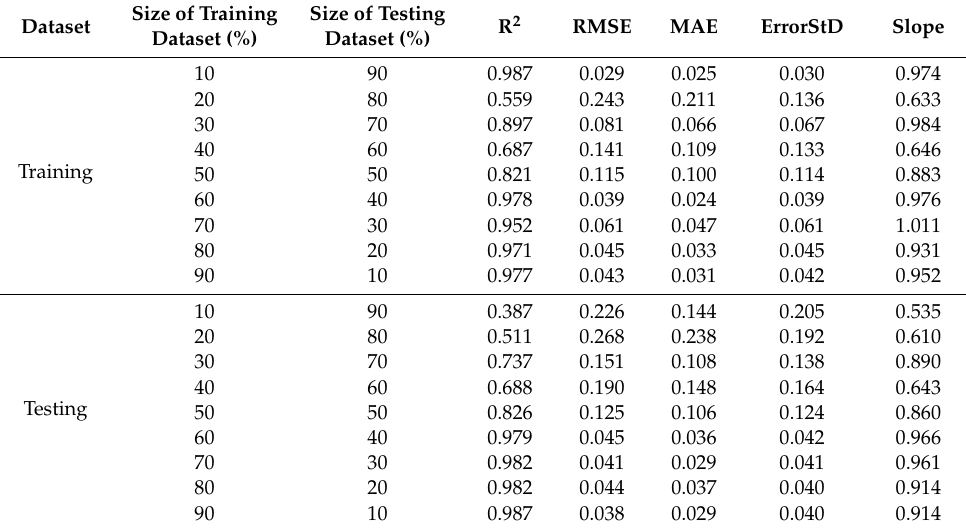
Figure 7. Influence of training set size with respect to ( a ) R 2 , ( b ) RMSE, ( c ) MAE, ( d ) ErrorStD, and ( e ) slope. Table 4. Summary of influence of training set size on the prediction results. RMSE, root mean square error; MAE, mean absolute